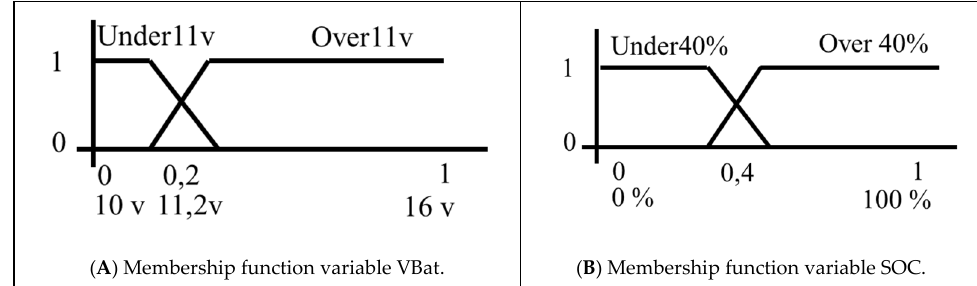
Figure 7. Discharge controller. Membership functions defined in each variable.